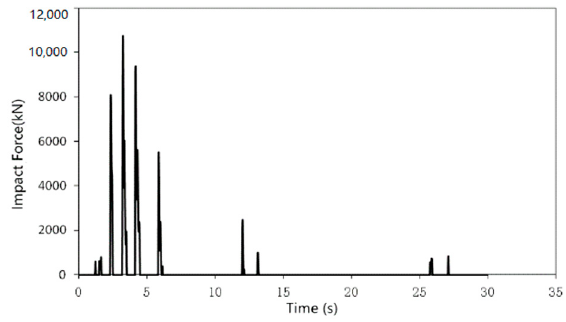
Figure 11. Time-history curve of impact force for model A.